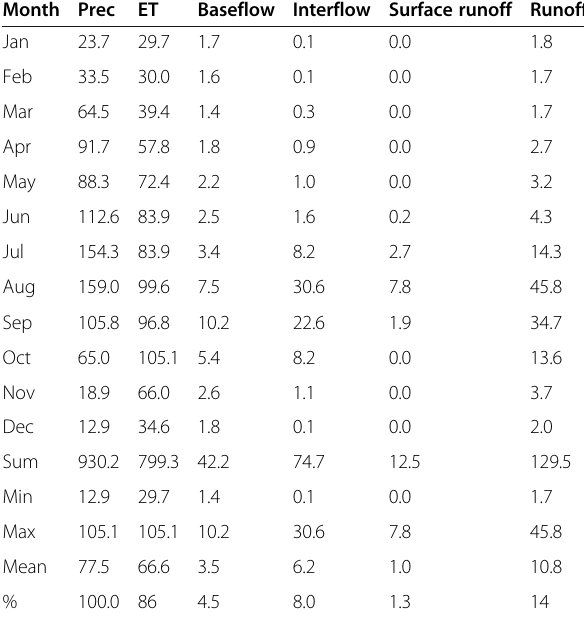
Table 6 Average monthly estimated depth of hydrologic components in the Ketar subbasin (in